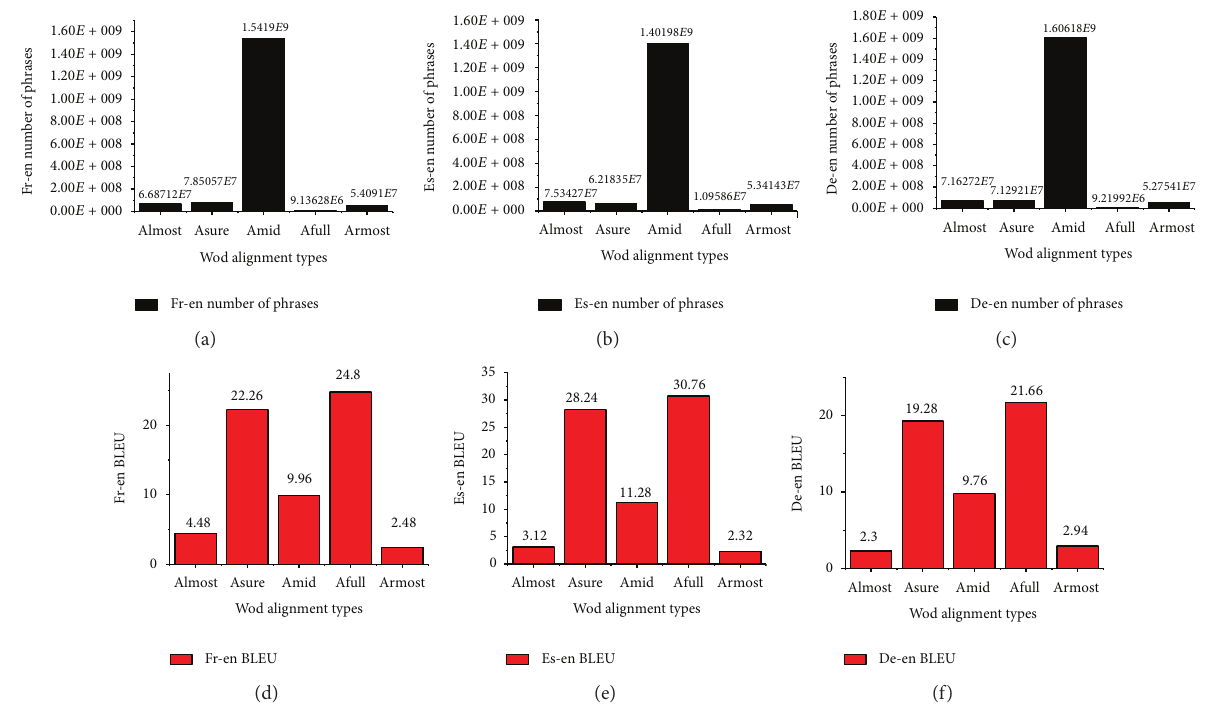
Figure 7: Number of phrases extracted from different word alignment points and their